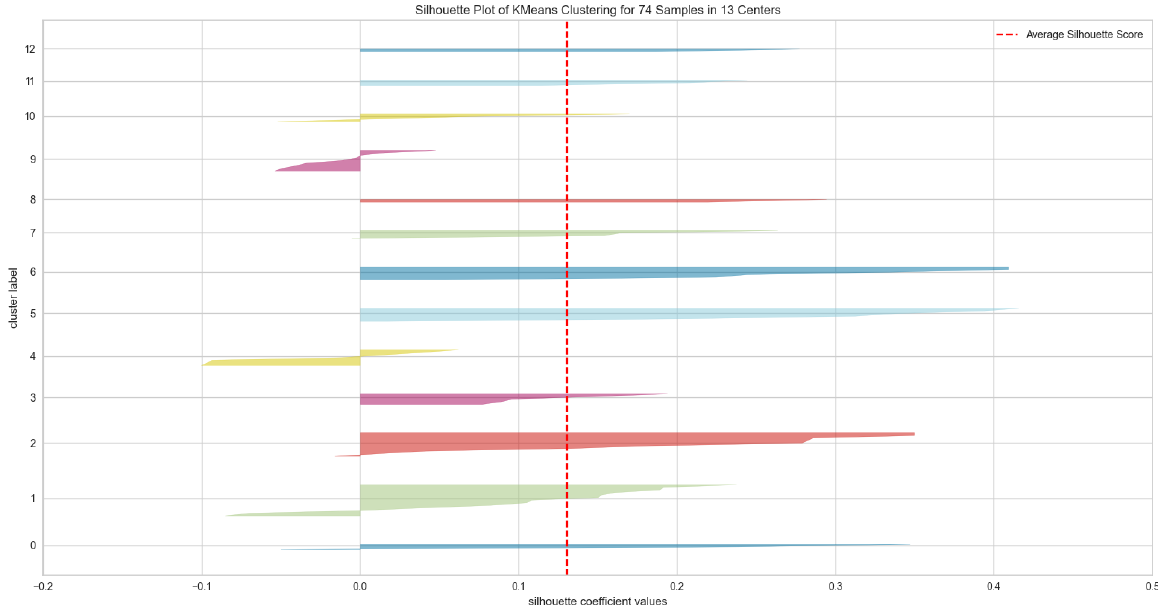
Figure 6. Optimal number of clusters using elbow method.